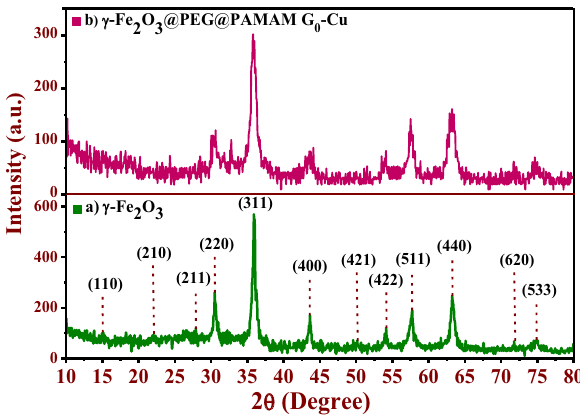
Figure 5. XRD patterns of ( a ) γ ‒ Fe 2 O 3 , and ( b ) γ-Fe 2 O 3 @PEG@PAMAM G 0 -Cu catalyst.